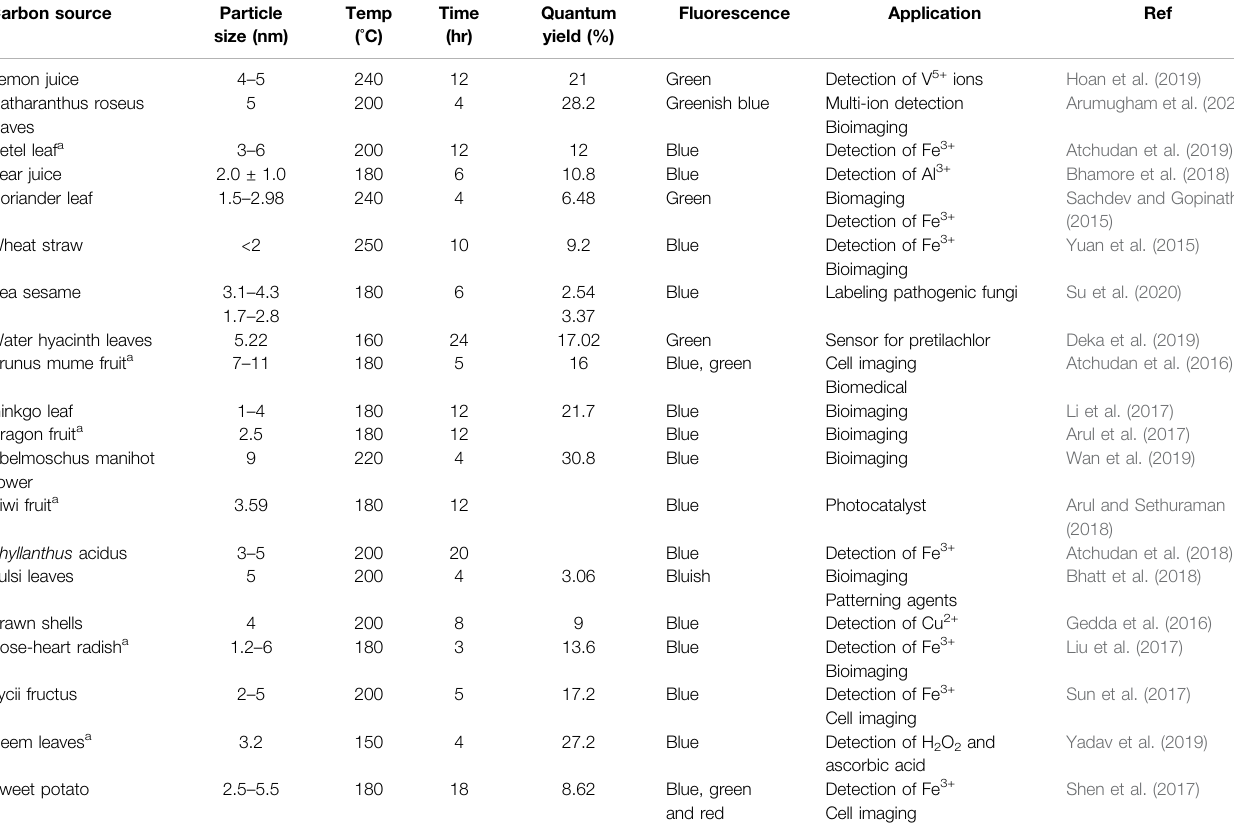
TABLE 2 | Summary of the properties and applications of C-Dots prepared by using various green precursors via hydrothermal approach. Carbon